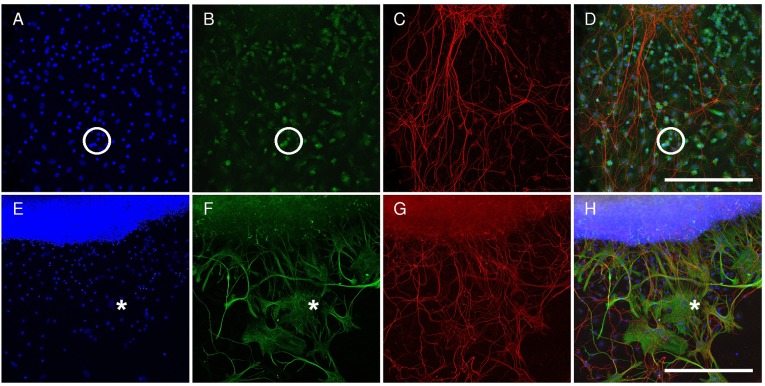
Immunohistochemical analysis of cells migrating out of ischemic retinal explants.Retinal explants were transferred onto laminine-1 coated cultures for six days to allow RGC regeneration. Next, explants were analyzed by immunohistochemistry. Different cell types migrated out of the retinal explants during the time in culture. (A+E) Two types of DAPI-positive nuclei were apparent: smaller (circle) and bigger (asterisk). (B+D) The smaller nuclei belonged to iba-1 positive microglia cells (circle). (F+H) The bigger nuclei belonged to GFAP-positive Müller cells and astrocytes (asterisk). (C+G) Both glial cell types did not compromise the growth behavior of the beta-III tubulin positive RGC axons. Scale bar upper row 300 μm, lower row 600 μm.